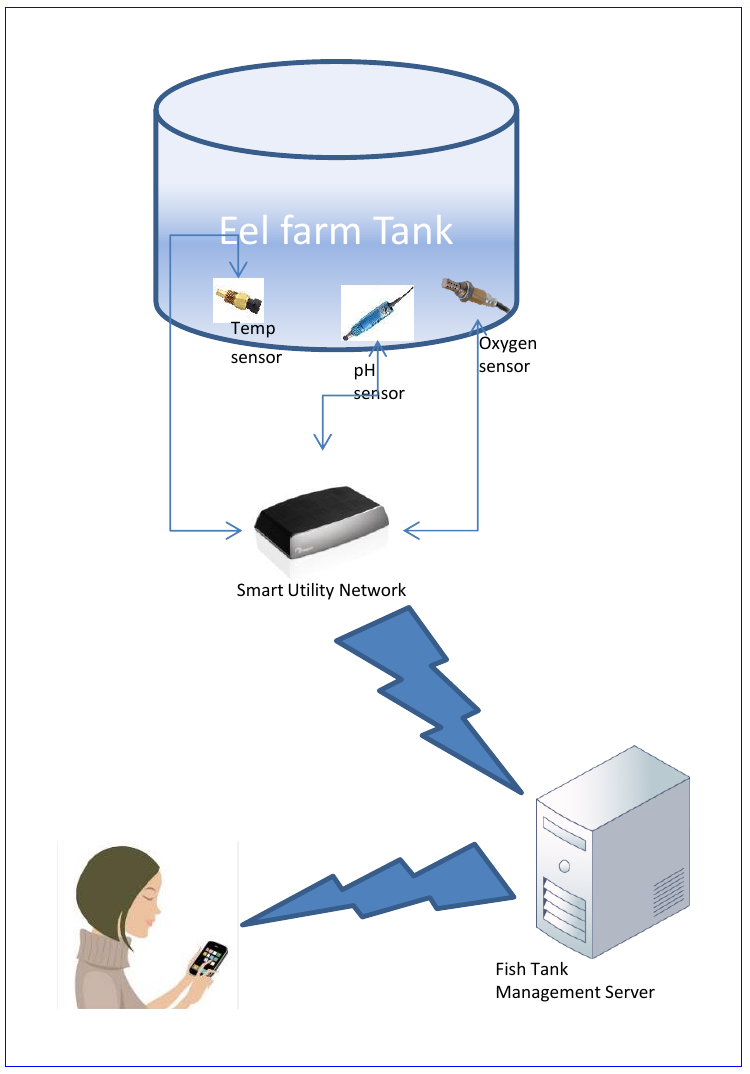
Figure 1. SK (Sunkyong) Telecom design of IoT based fish farm management